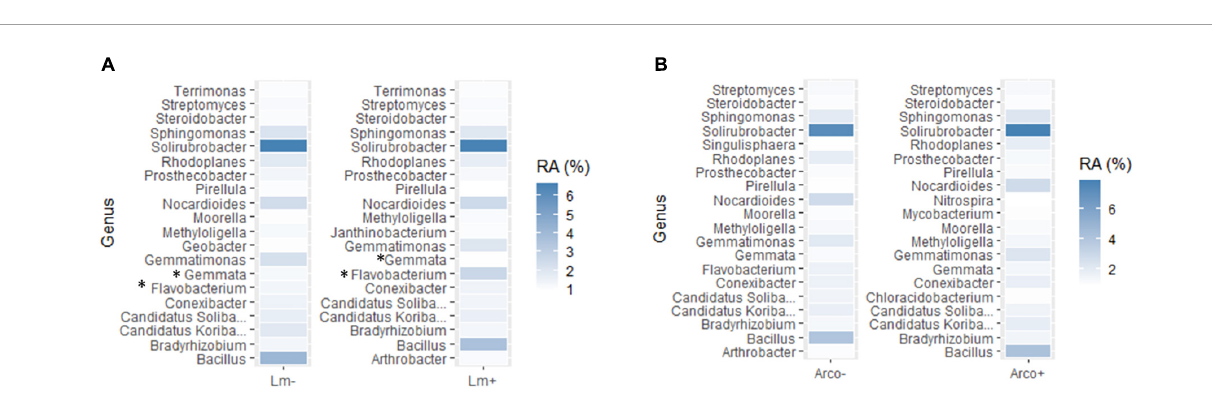
FIGURE10 (A) Top (most abundant) twenty genera detected (16S) in Lm negative (–) samples vs. top 20 genera detected in Lm positive (+) samples in OH soil. (B) Top twenty genera detected in Arcobacter negative (–) samples vs. top 20 genera detected in Arcobacter positive (+) samples in OH soil. The darker the color, the more abundant the genus, i.e., the higher the relative abundance (%). An asterisk ( ∗ ) denotes genera with significantly different mean relative abundance between positive and negative samples. RA, mean relative